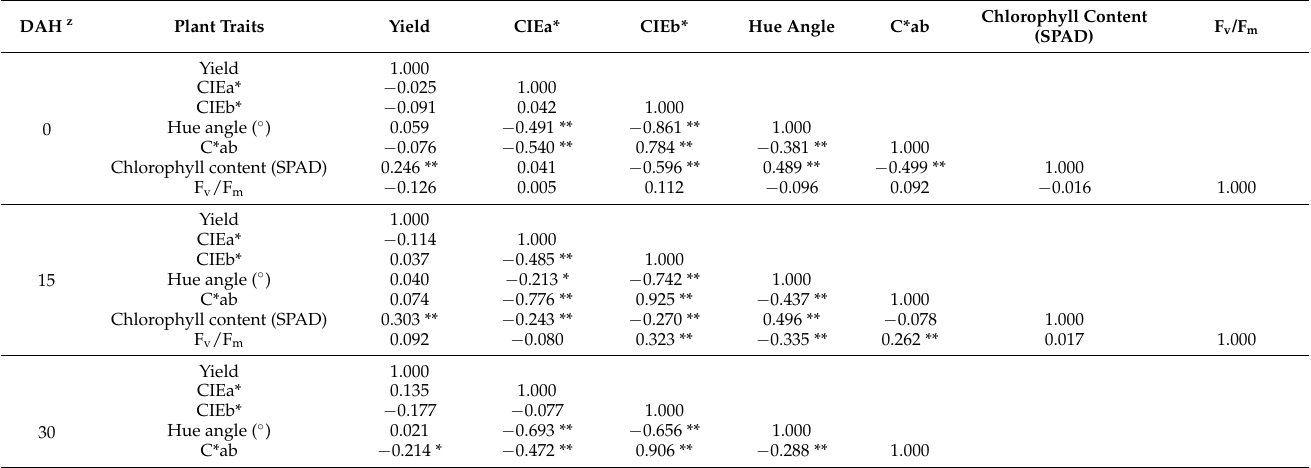
Table 2. Analysis of correlation between leaf color, chlorophyll content, and F v /F m in CNDH line. DAH z Plant